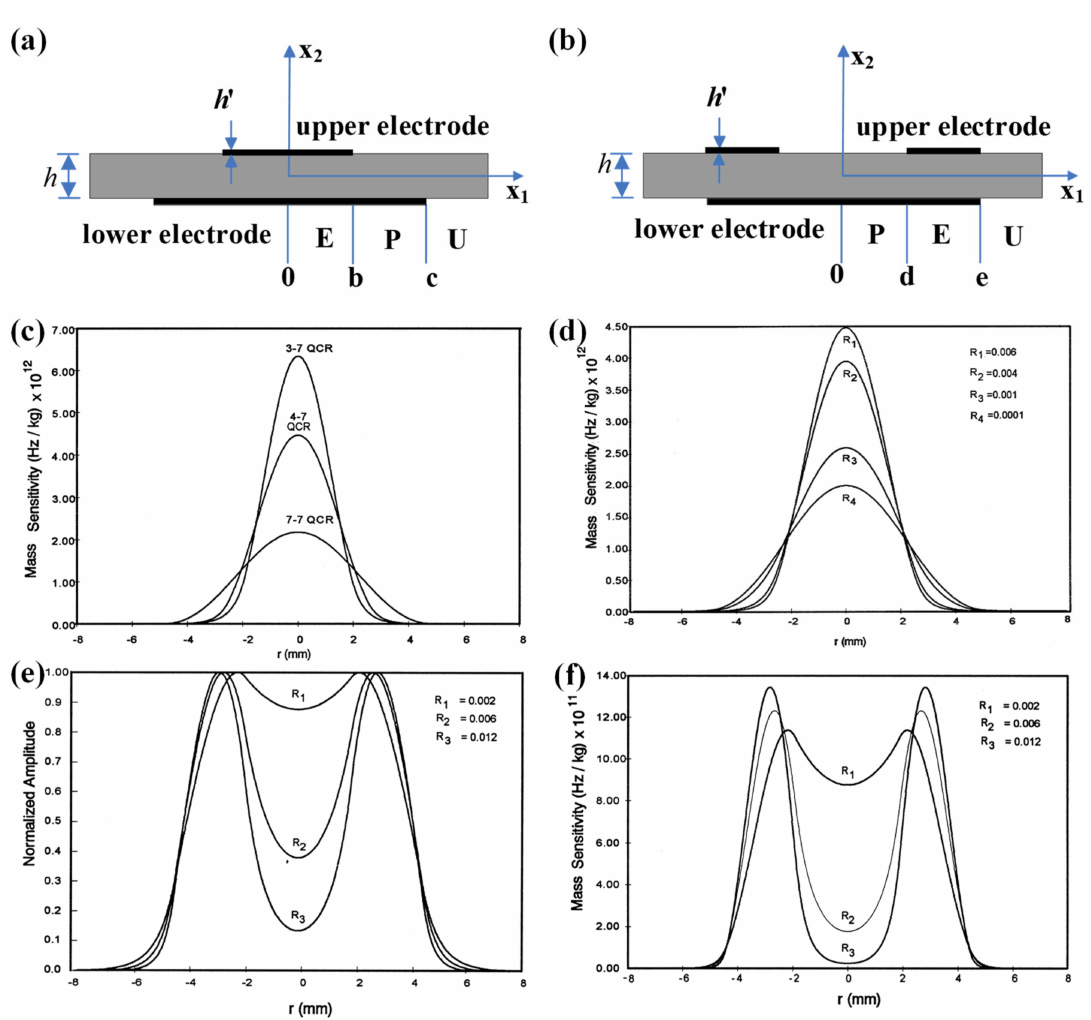
Figure 3. Schematic diagram of the structure of the ( a ) n-m electrode QCM and ( b ) ring electrode QCM. The mass sensitivity distribution function of n-m electrode 11 MHz AT-cut QCMs under ( c ) different diameters and ( d ) different mass loading factors. ( e ) Particle displacement amplitude profile and ( f ) mass sensitivity distribution function of ring electrode 11 MHz AT-cut QCMs [39]. b and c are the radii of the upper electrode and lower electrode for the n-m electrode QCM, respectively. d and e are the radii of the inner and outer electrode,